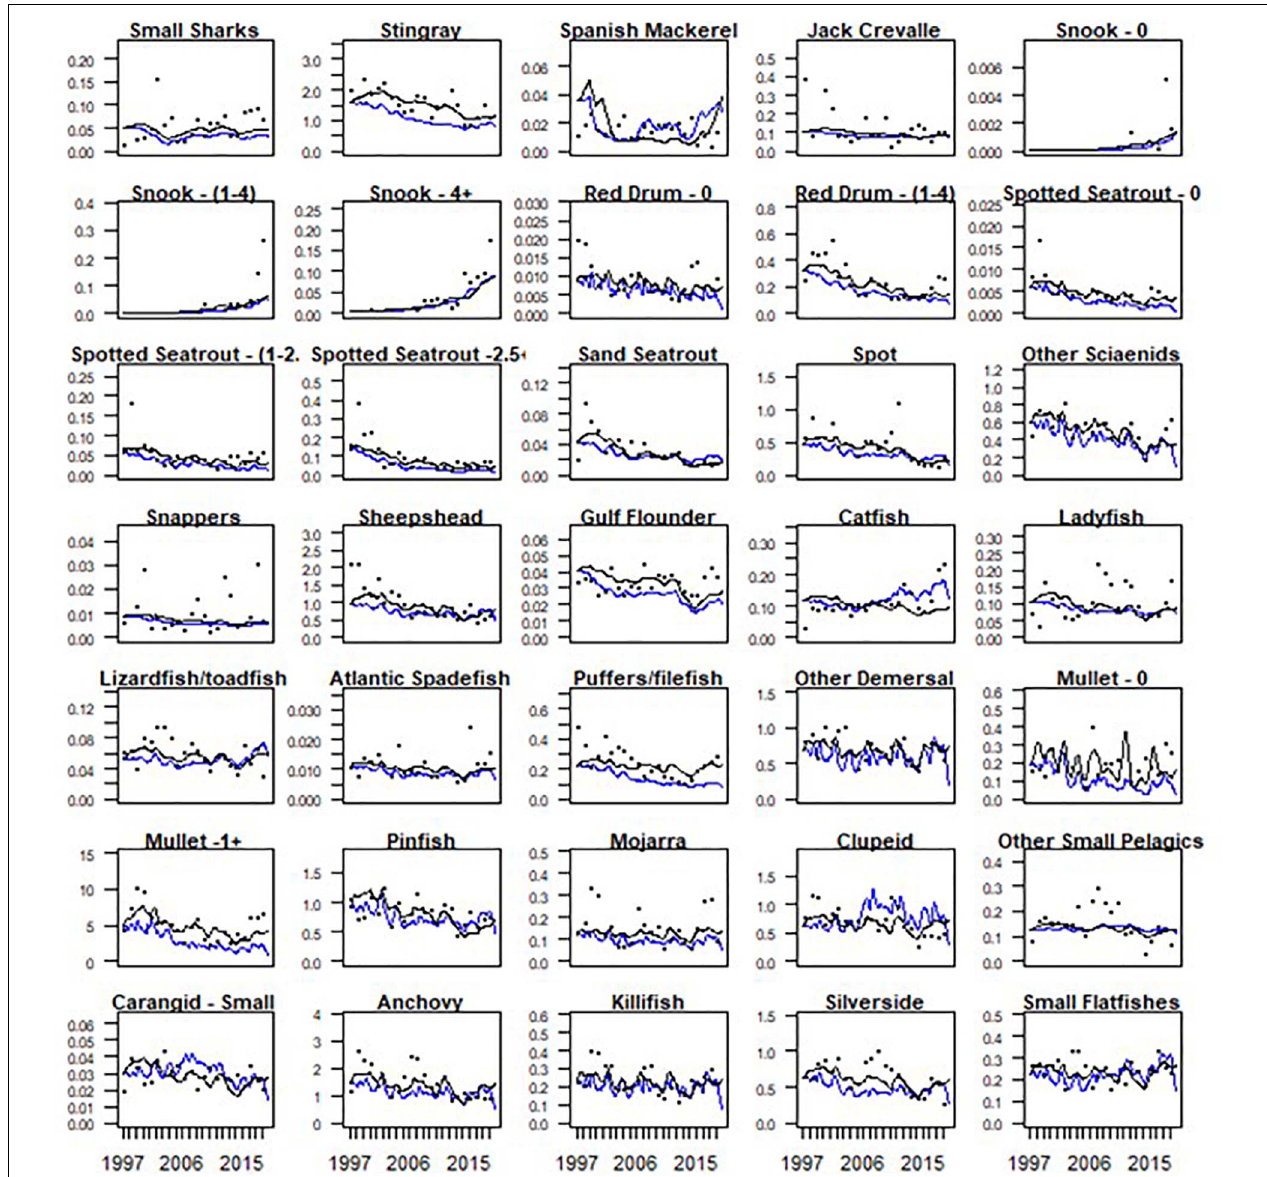
FIGURE 5 | Model fits of all finfish. Black line represents model fits for the nutrient scenario. Blue line represents model fits for the discharge